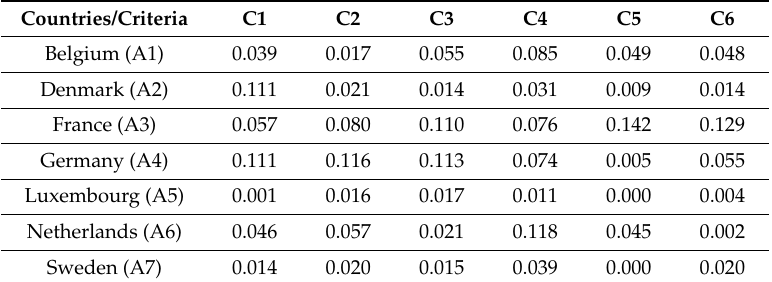
Table 11. The weighted criterion matrix.